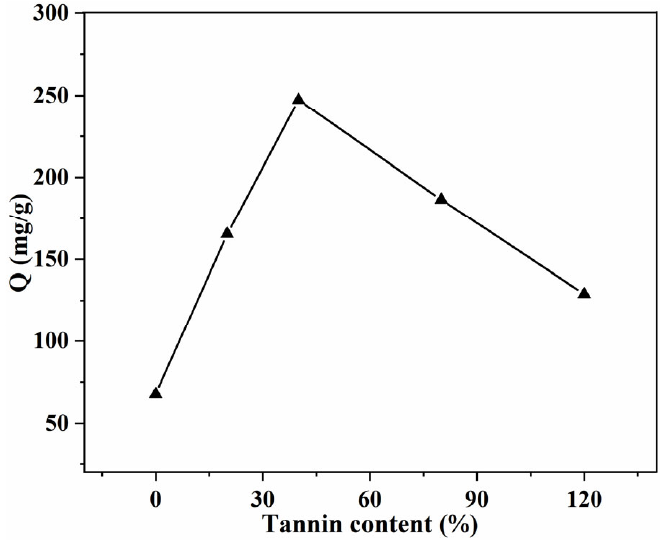
Figure 8. Effect of Tan content on the adsorption capacity ( C 0 = 200 mg/L, pH = 12, T = 45 °C, t = 24